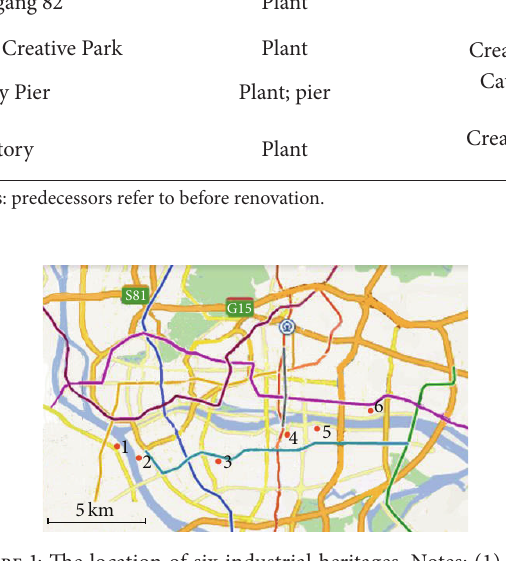
Figure 1: The location of six industrial heritages. Notes: (1) Xinyi Place (Xinyi International Place); (2) Taikoo Wharf; (3) Xingang 82 (Guangzhou Textile Exchange Park); (4) T.I.T Creative Park; (5) Party Pier (Zhujiang Party Pier Beer Culture & Art Zone); (6) Redtory.